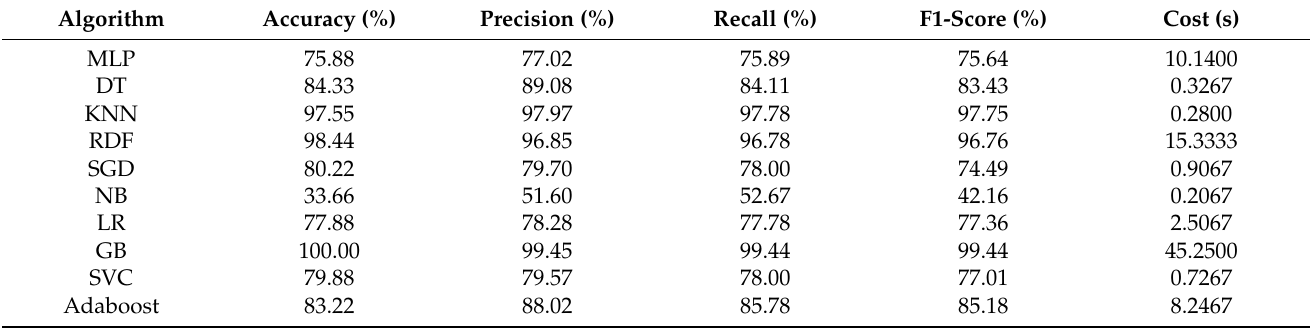
Table 13. Global performance comparison of ML models using combination of (Q) and (Z)